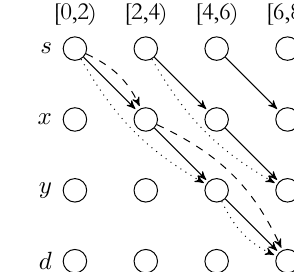
Standard chain decomposition. Most of the polynomial time dynamic flow algorithms are based on the temporally repeated static flow solutions introduced by Ford and Fulkerson (1962). By considering the constant arc travel times as costs, they decompose the obtained maximum flow minimum cost static flow solution (cid:9) : A ! R + into p -chains (paths) (cid:13) k , denoted by (cid:0) = f (cid:13) 1 ; (cid:13) 2 ; : : : ; (cid:13) p g , each carrying the value val ( (cid:13) k ) to the sink such that (cid:9) = This standard chain decomposition uses its chain flows in the same direction as (cid:9) does. The decomposition (cid:0) of a feasible static flow (cid:9) yields a feasible dynamic flow for given finite time horizon T by pushing the flow values of each chains from zero till the time permits, for example till time T (cid:0) (cid:28) ( (cid:13) ) for the chain (cid:13) in (cid:0) , whenever this chain has length at most T . The (cid:0) -induced dynamic flow value denoted by (cid:0) T equals to val ((cid:8) ; T ) for (cid:8) , which depends only on (cid:9) and not on a particular choice of any standard chain decomposition, can be expressed